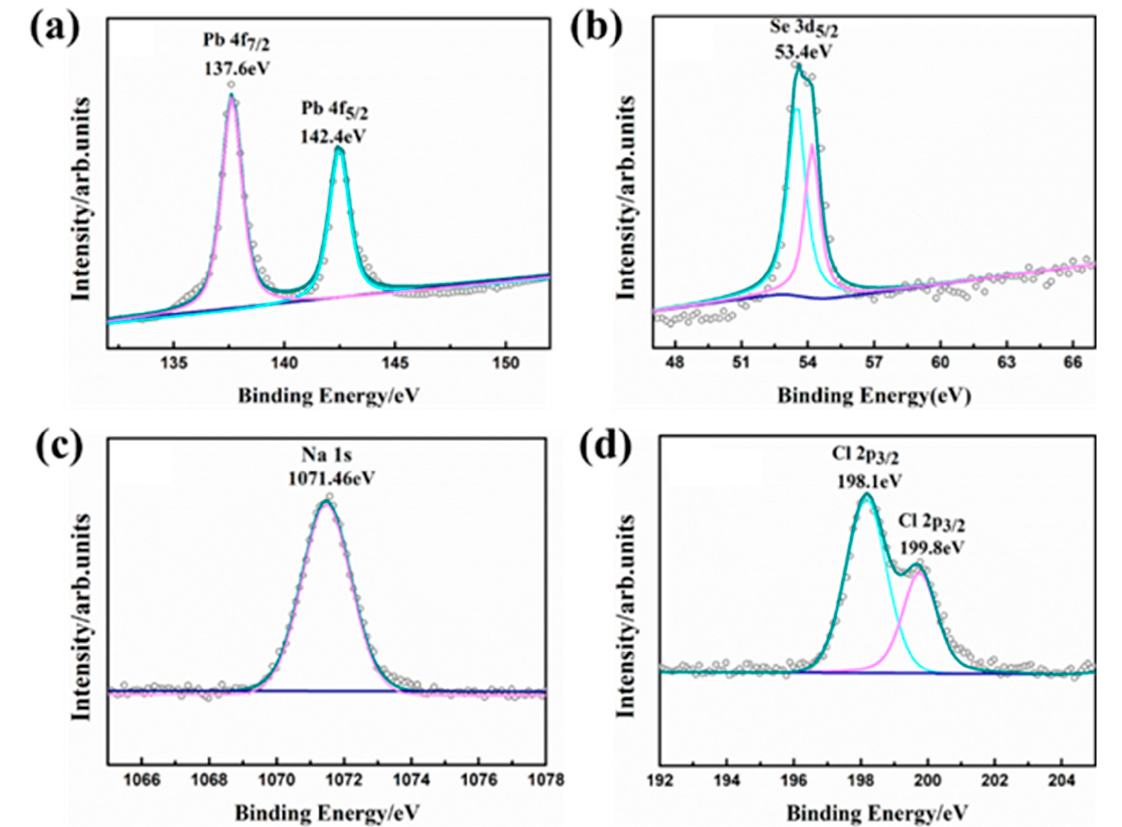
Figure 3. XPS fi tt ings for Pb 4f ( a ), Se 3d ( b ), Na 1s ( c ), and Cl 2p ( d ). Figure 3. XPS fittings for Pb 4f ( a ), Se 3d ( b ), Na 1s ( c ), and Cl 2p ( d